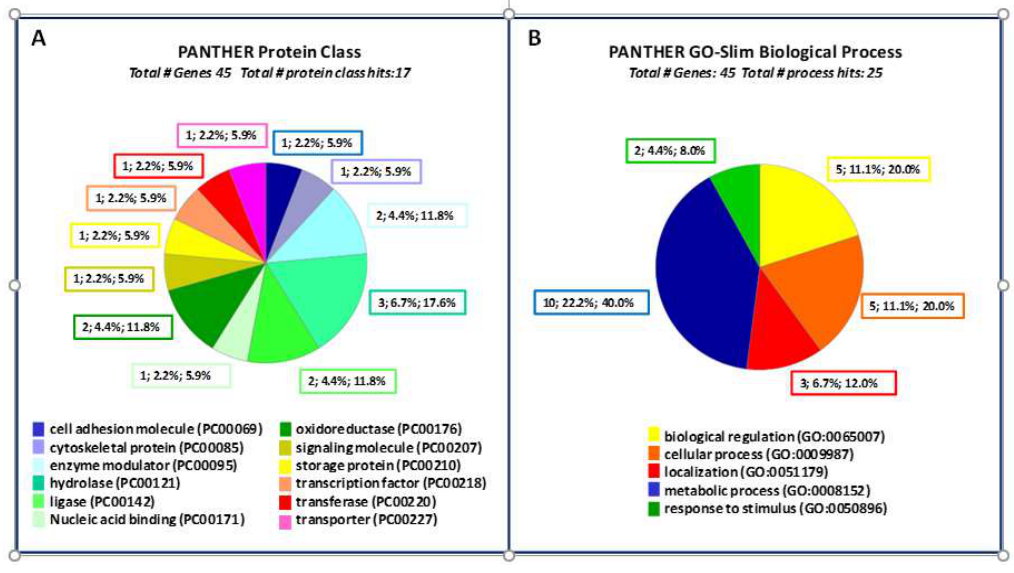
Figure 3. PANTHER functional classification viewed in pie chart. ( a ) Protein Class; ( b ) Biological PANTHER functional classification viewed in pie Process.